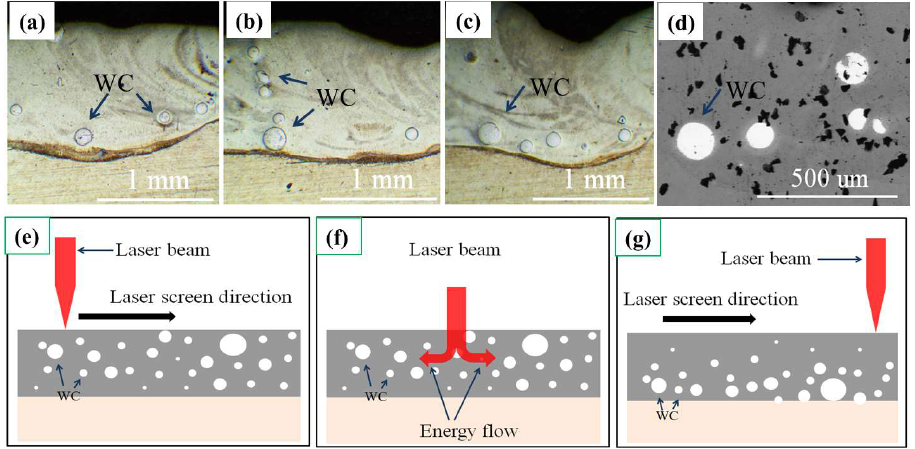
Figure 3. ( a – c ) are the OM morphology of the AlCoCrFeNi/WC coating in the different parts; ( d ) is the back-scattered electron image of the AlCoCrFeNi/WC coating; ( e – g ) are the schematic diagrams before and after laser